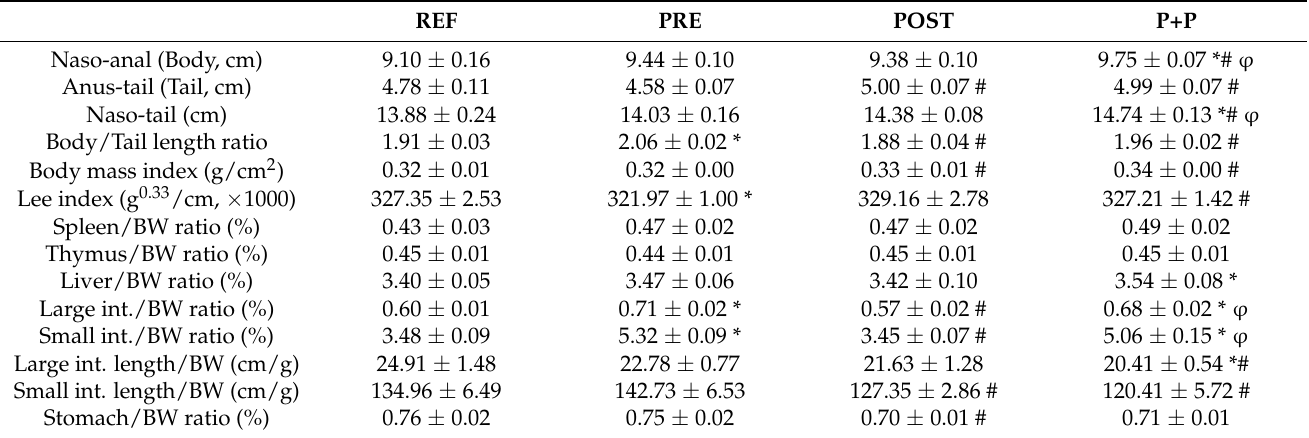
Table 1. Growth-associated measurements and relative weight of organs at the end of the study (day 16 of